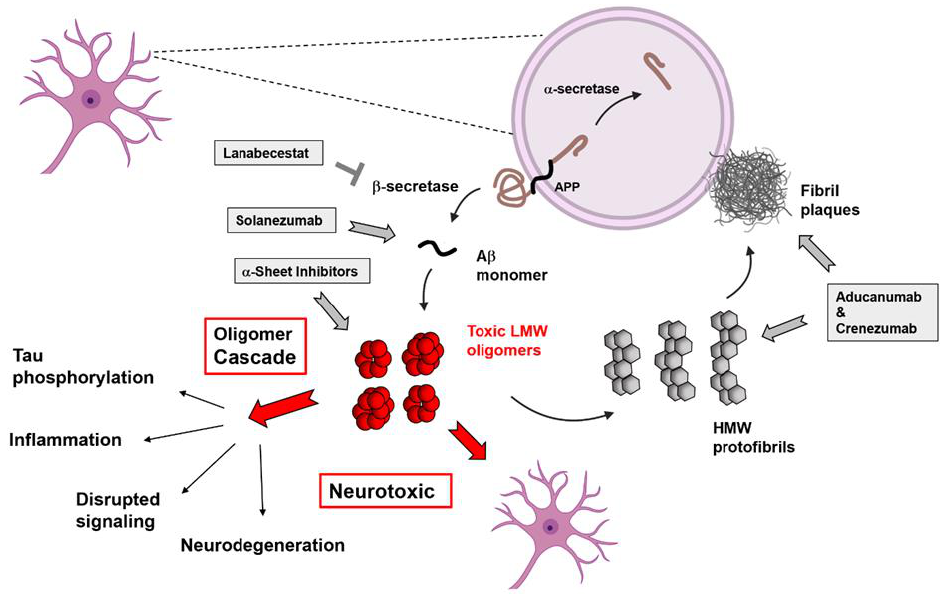
Figure 3. Drug candidates and their associated targets. Processing of APP by β -secretase produces monomeric, native A β . A β undergoes a misfolding event that eventually produces LMW oligomers that are neurotoxic and initiate the oligomer toxicity cascade. These eventually progress to HMW protofibrils that finally deposit as fibril plaques at the neuronal membrane. Lanabecestat™ is a BACE inhibitor that reduces processing of APP to produce A β monomer, while Solanezumab™ is a monomer (sequence) specific drug. Crenezumab™ specifically targets the β -sheet rich HMW protofibrils and fibrillar plaque deposits, while Aducanumab™ specifically targets the β -sheet fibril plaques.